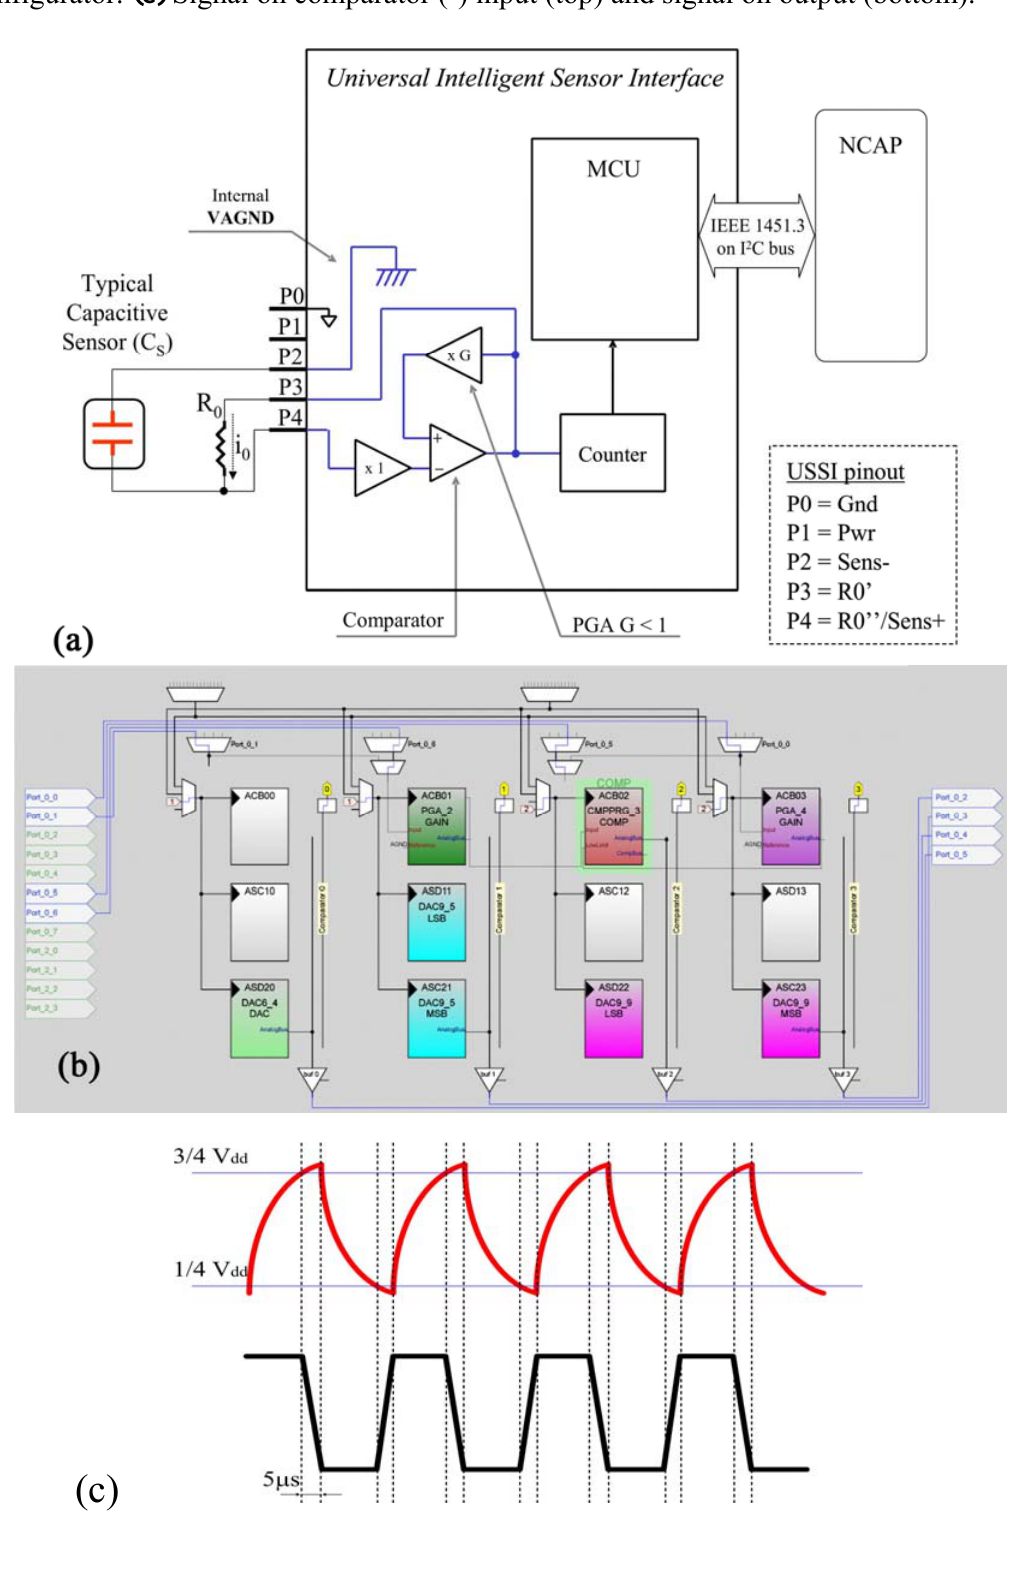
Figure 9. Capacitive sensors: (a) Logical scheme of UISI conditioning front-end and (b) screen-shot of related implementation in PSoC device through by means of Graphic Configurator. (c) Signal on comparator (-) input (top) and signal on output